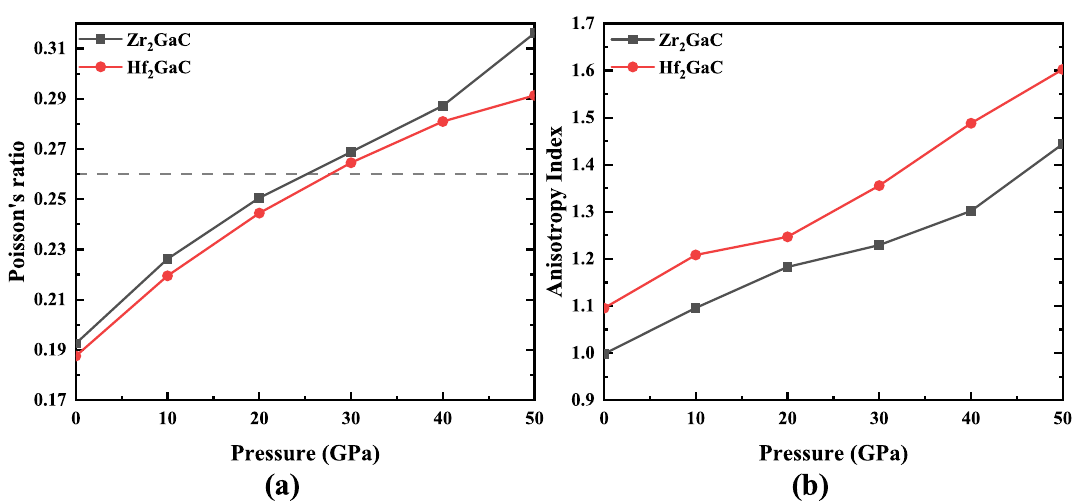
Figure 11. Variation of a Poisson’s ratio (σ), and b Anisotropic Index (A) for the M 2 GaC MAX phase (M = Zr, Hf) in function of pressure. The horizontal line in ( a ) is the proposed borderline between brittle and ductile